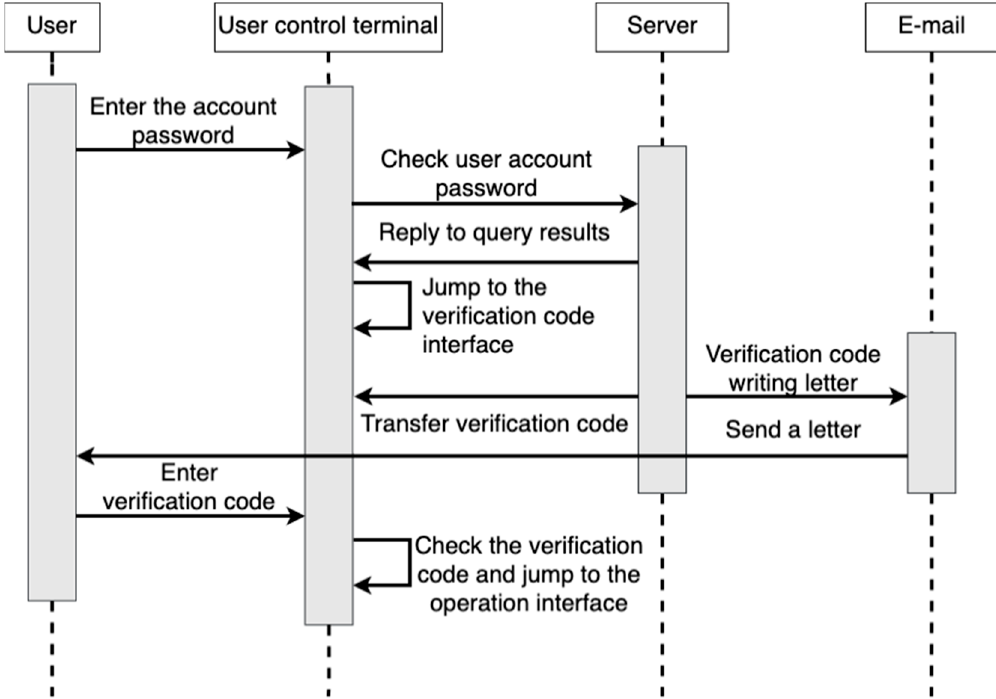
Figure 13. Sequence diagram of user control terminal login.